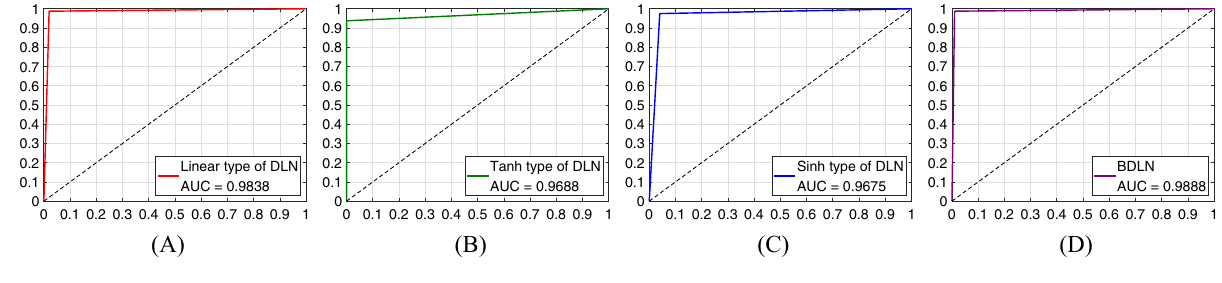
Figure 9. Receiver operating characteristic curves (ROC curves) of dynamic learning networks (DLN) and bagging dynamic learning network (BDLN) in case 1. ( A ) DLN trained by NDLA with linear type of mapping function. ( B ) DLN trained by NDLA with tanh type of mapping function. ( C ) DLN trained by NDLA with sinh type of mapping function. ( D ) Bagging dynamic learning network (BDLN) classifier.